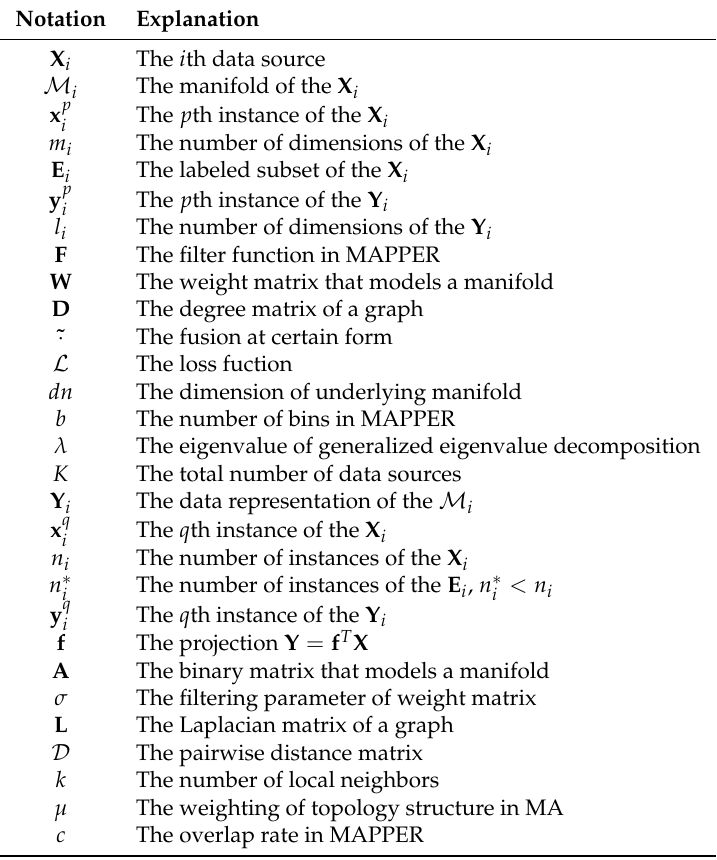
Table 1. The notations used in this